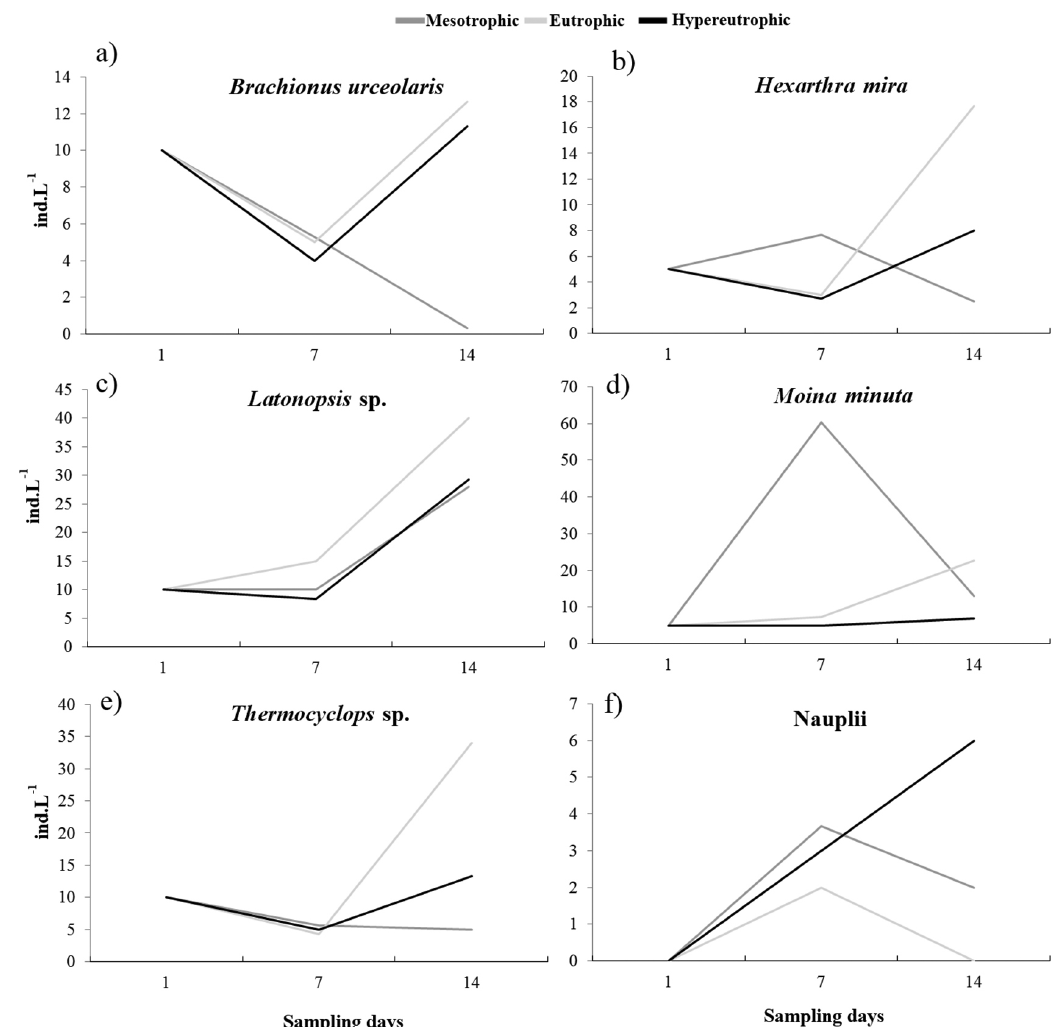
Figure 1. Temporal variations in the densities of Brachionus urceolaris (a), Hexarthra mira (b), Latonopsis sp. (c), Moina minuta (d), Thermocyclops sp. (e) and nauplii (f) on three experimentally simulated trophic conditions (mesotrophic, eutrophic and